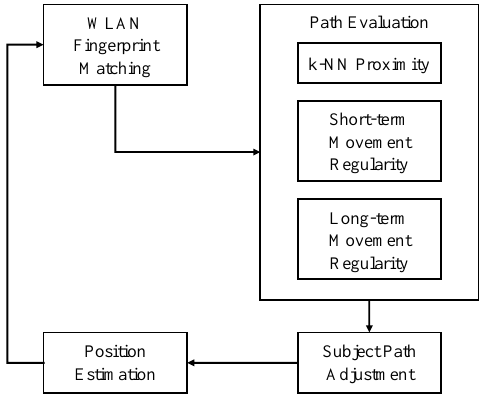
Figure 8. Location Estimation process of k NN +